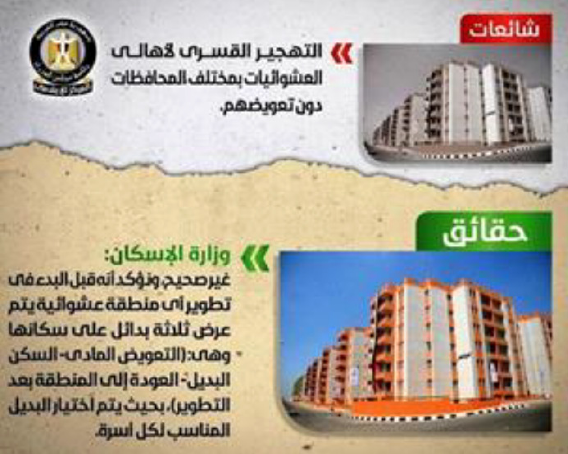
Figure 3. Official announcements to respond to rumors regarding Al‐Asmarat through online channels. Note: translation— “The rumor: Forced eviction for ashwa’eyat residents without compensation. Facts: Ministry of Housing: Not true, as we confirm that before developing any ashwa’eyat area, three alternatives are offered—financial compensation, alternative housing, returning to the area after development—and the appropriate alternative is chosen for each family.” Source: ExtraNews (2020).